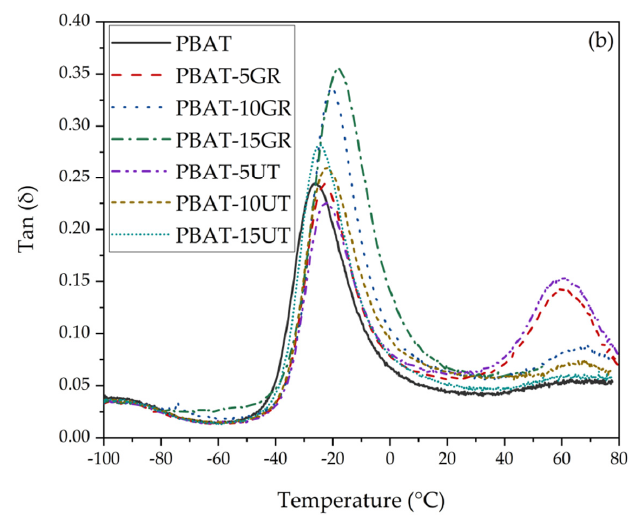
Figure 4. ( a ) Logarithm of storage modulus (G’) and ( b ) loss factor (tan δ ) of PBAT and PBAT resin-based formulations vs. temperature.